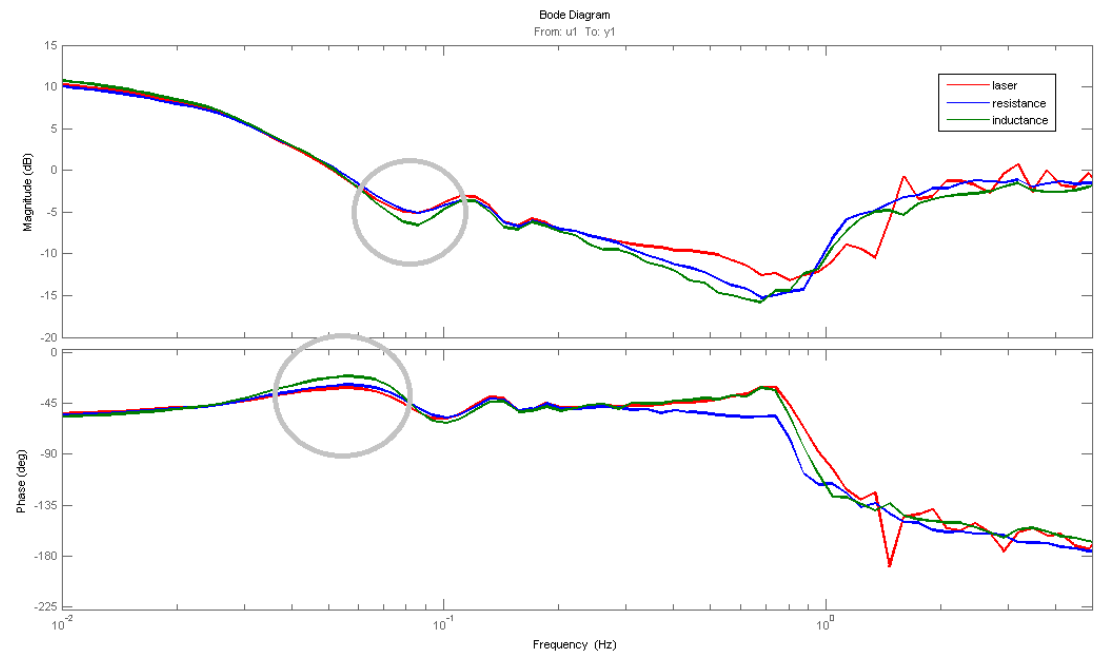
Figure 7. Bode diagram of IPMC calculated with the outputs of laser and inductive